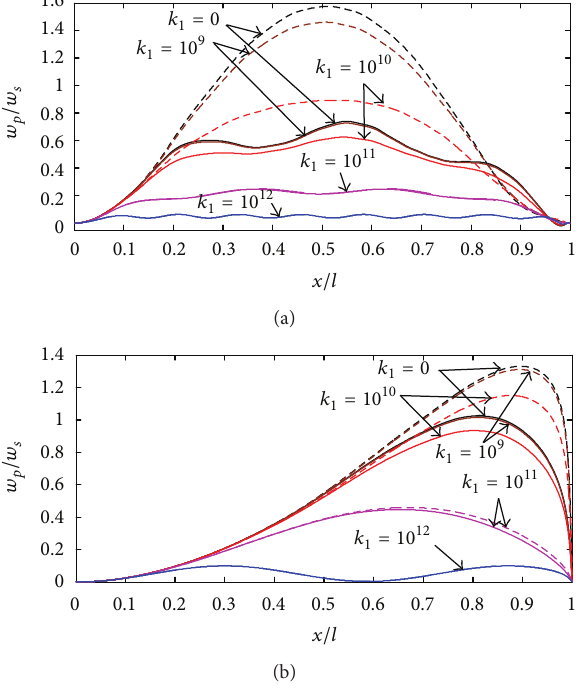
Figure 7: Variation of dimensionless instantaneous dynamic lateral deflection, 𝑤 𝑝 /𝑤 𝑠 , versus normalized instantaneous position of moving mass, 𝑥/𝑙 , of the Timoshenko beam with different 𝑘 1 values traveled at two different speeds with 𝑚 = 3𝜌𝐴𝑙 kg, 𝑐 = 10 3 N ⋅ s/m 2 , and 𝛽 = 0.3 . (a) 𝛼 = 0.11 , (b) 𝛼 = 0.5 ; (- - - - -) M-1 model and (—) M-2 or M-3 model with 𝑘 3 = 10 22 N/m 4